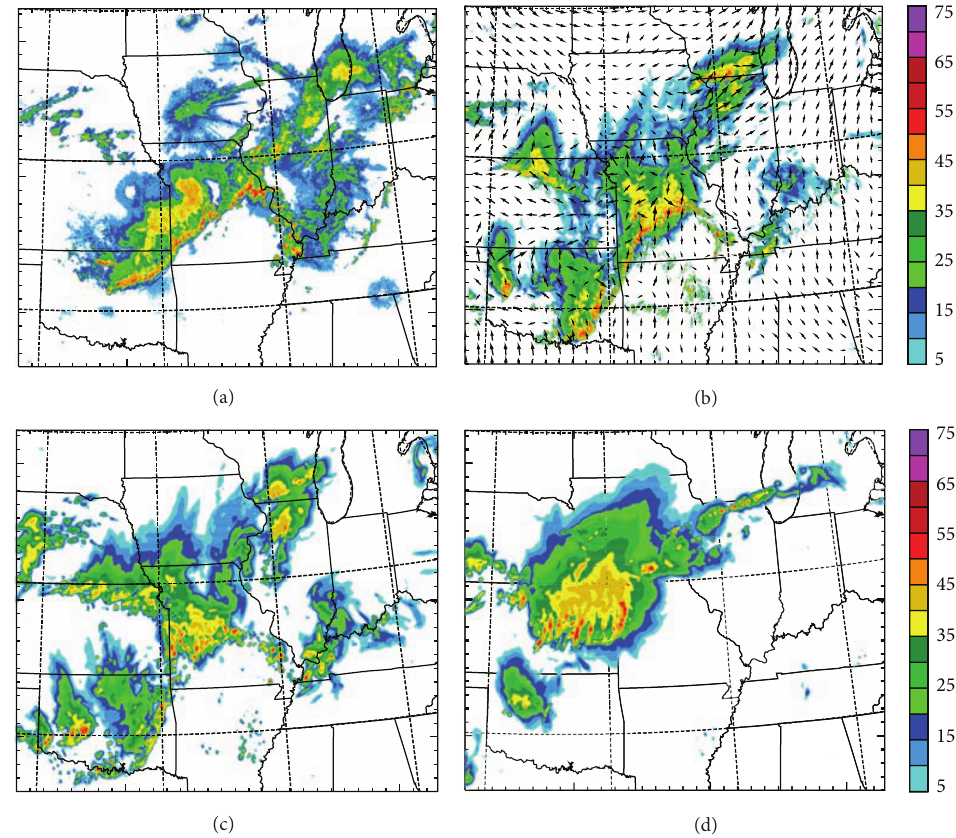
Figure 2: As Figure 1 but valid at 0900 UTC, 26 May 2008, corresponding to 9-hour forecast time and for a selected Midwest